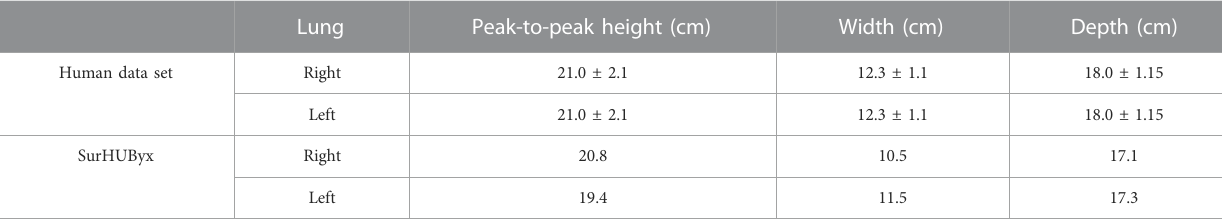
TABLE 3 Comparison of linear dimensions between SurHUByx and a human data